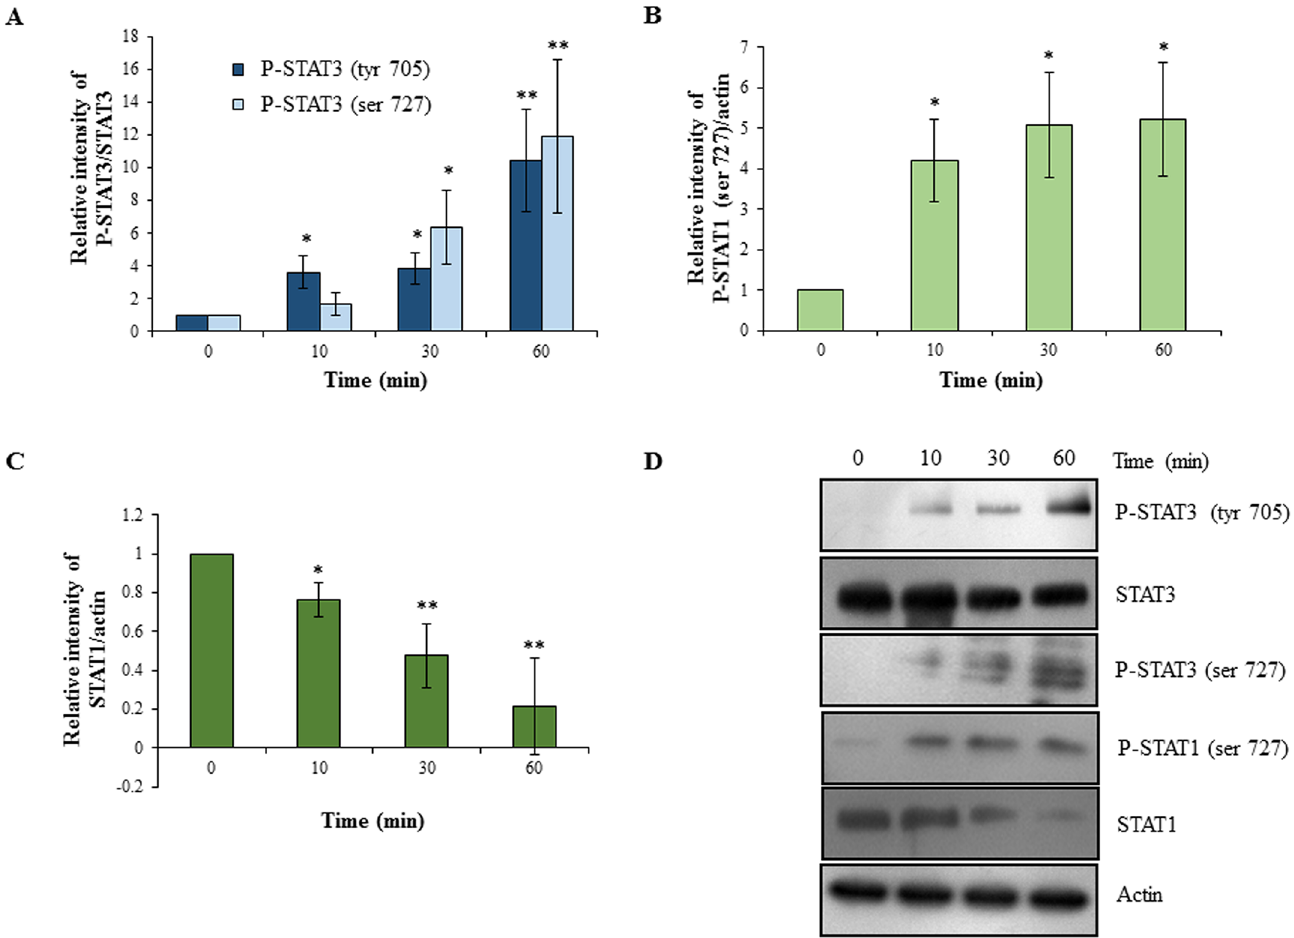
Fig 2. Activation of STAT3 and STAT1 dependent signaling following EGF treatment of HTR-8/SVneo cells. HTR-8/SVneo cells were treated with EGF (10 ng/ml) for varying time periods followedby Western blot analysisto determine activationof STAT1 and STAT3 as describedin Materials and Methods . Panel A representsthe densitometric plot showingrelativeincrease in phosphorylated STAT3 (ser 727 and tyr 705) levels in EGF treated cells with respect to untreatedcontrol as comparedto total STAT3. Panel B representsthe densitometric plot showingrelativeincrease in phosphorylated STAT1 (ser 727) levels in EGF treated cells with respect to untreatedcontrol as comparedto actin. Panel C represents the densitometric plot showingrelativedecrease in total STAT1 levels in EGF treated cells with respect to untreatedcontrol as comparedto actin. Panel D shows representative blots from one of the three independent experiments. The data in Panels A, B and C is representedas mean ± SEM of three independentexperiments and band intensitiesof phosphorylated and total STAT1 & STAT3 were normalized with respect to loadingcontrol during densitometric analysis. * p < 0.05 and ** p < 0.01 with respect to untreatedcontrol